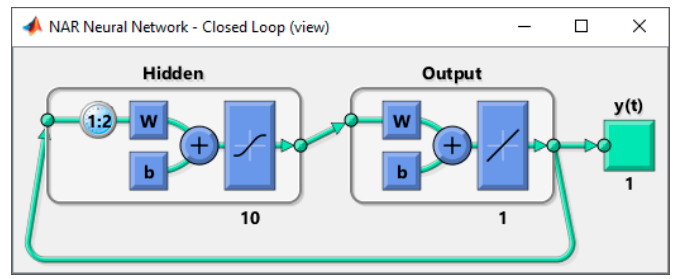
Figure 6. Diagram of a two-layer neural network in MATLAB.